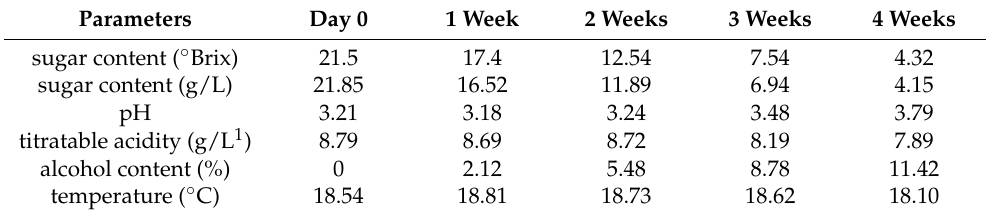
Table 1. Physicochemical measurements of must during the fermentation